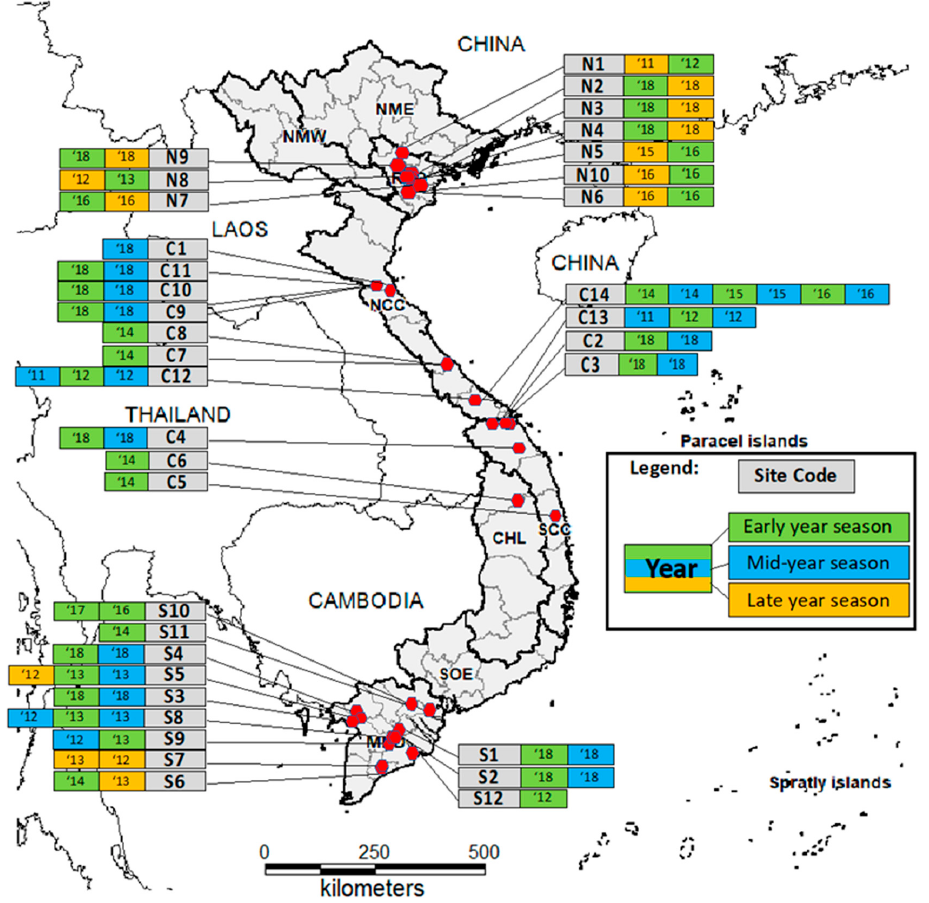
Figure 2. Overview of field sites and recorded seasons.